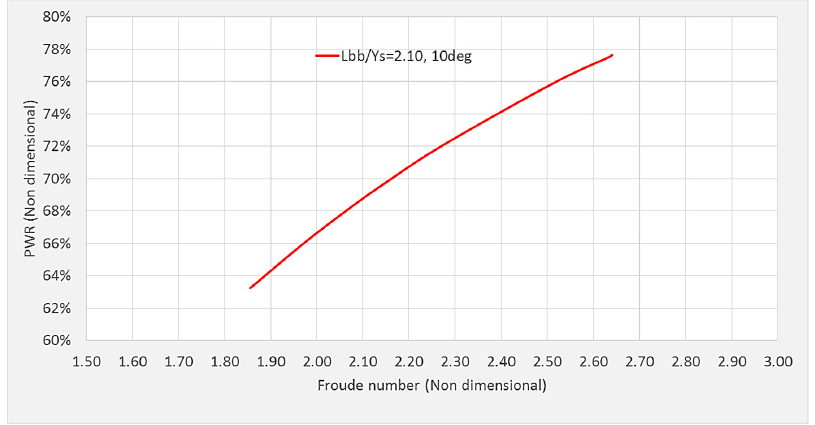
Figure 26. Proposed PWR approximation using normalize bulb length, 10 ˚ pitch angle, L bb = 0.786 ′ , Y s = 0.375.